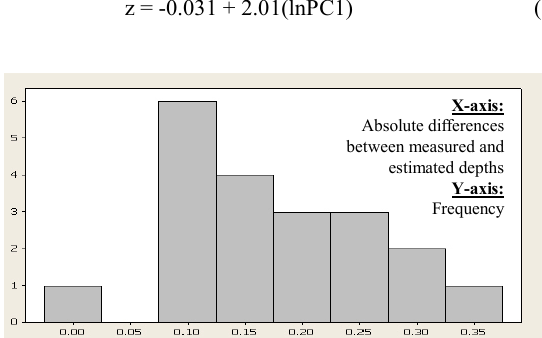
Figure 5. The histogramme of absolute differences between measured and estimated depths (area B). All of the differences are under 0.4m.